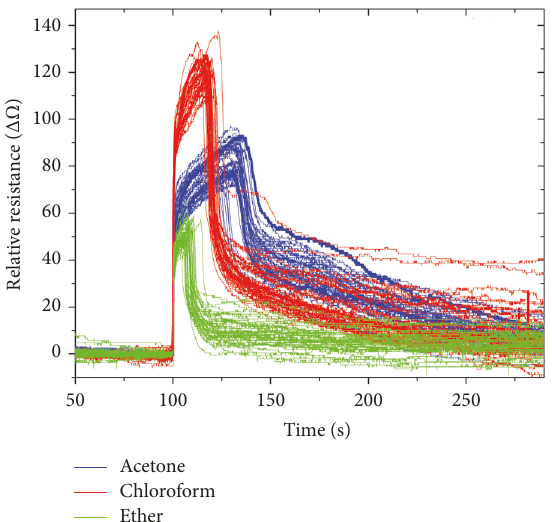
Figure 6: Time domain resistance curve of GFCS obtained with different chemical molecules: acetone, chloroform, and ether.